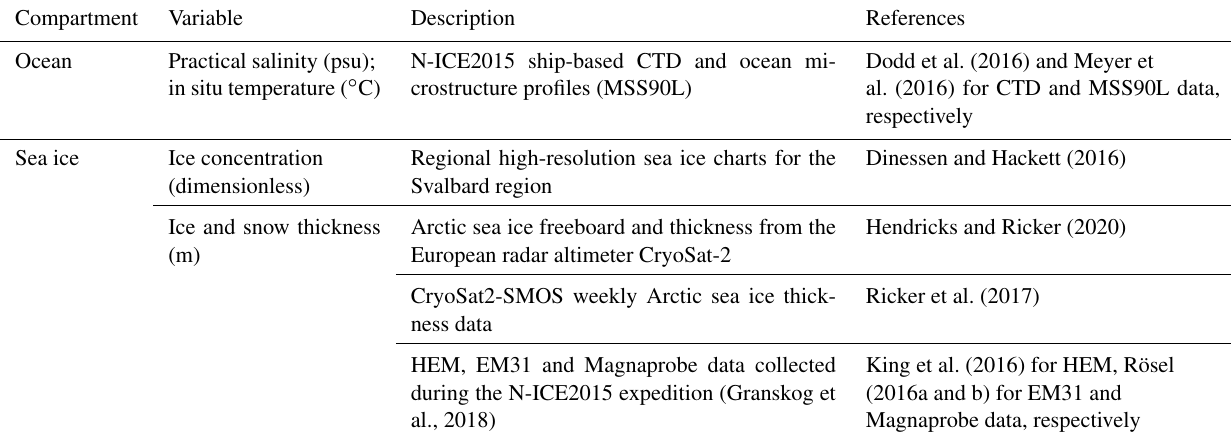
Table 5. Datasets used for S4K model evaluation. The listed references include links to the repositories where data and details on sampling and data processing can be found. CTD – conductivity–temperature–depth; MSS90L – ocean microstructure profiler; HEM – helicopter- borne electromagnetic induction sounding; EM31 – ground-based electromagnetic